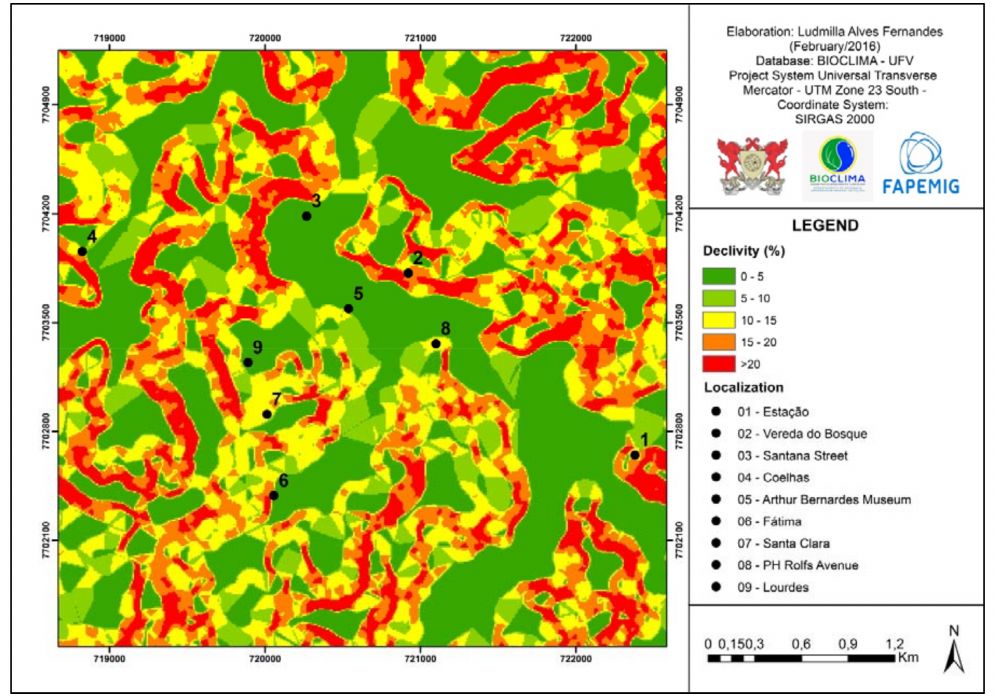
Figure 3. Map of declivity of data points in the municipality of Viçosa (MG). Data source: BIOCLIMA—UFV Organization: Ludmilla Alves